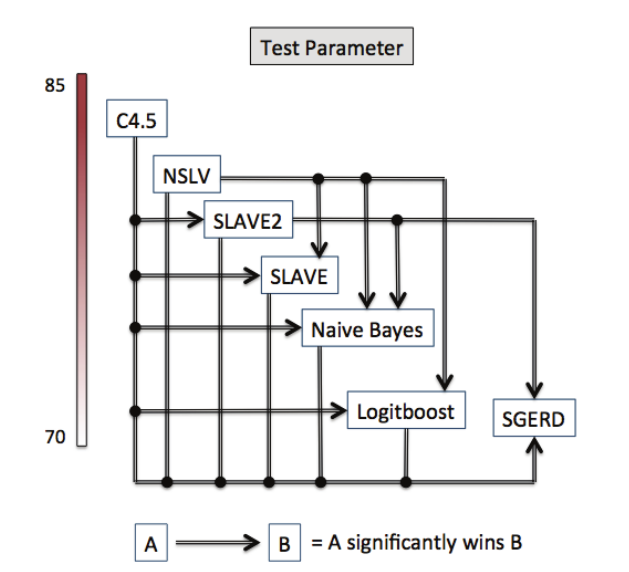
Fig. 10. Representation of the significant differences be- tween the